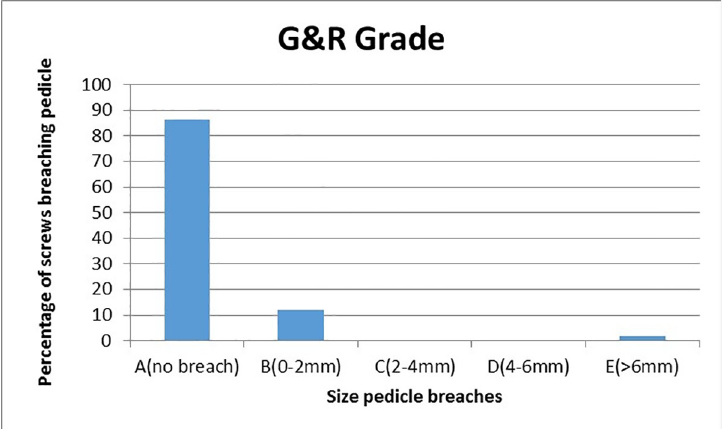
Fig 4. Column chart showing the percentage of screws breaching the pedicle wall according to the Gertzbein– Robbins criterion. Of all the 59 robotic-guided screws, 98.3% (58) were safely placed (Groups A or B), whereas 1.7% (1) breached the intrapedicular trajectory (Group